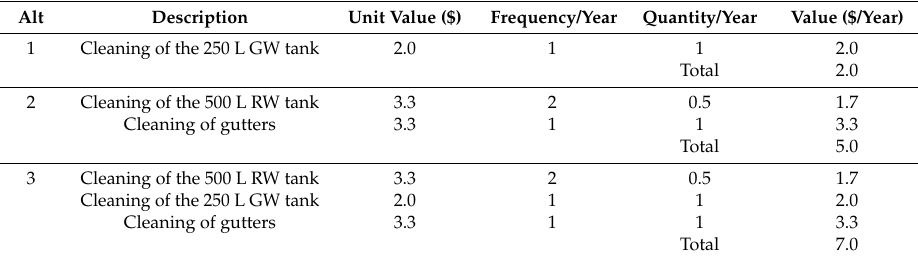
Table 4. Maintenance costs of the proposed systems.